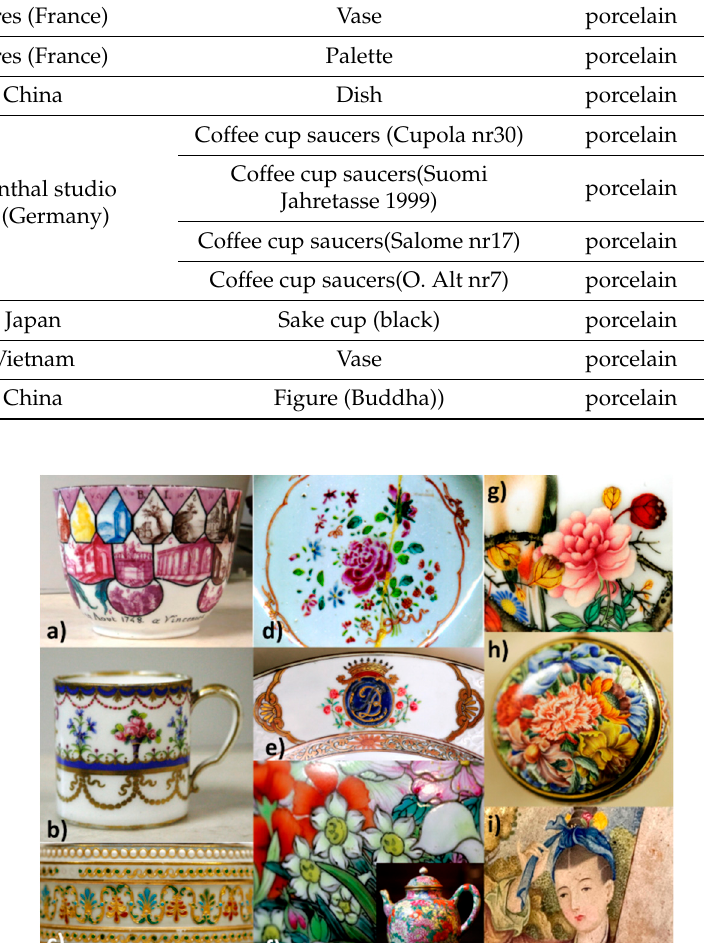
Figure 2. Selection of objects representative of the variety of colored decorations obtained with enamel on porcelain or metal during 19th century: ( a ) color palette (MNC2003, Sèvres), soft-paste porcelain enamels from Sèvres Factory, 1798, reproduced with permission from Ref. [2], 2001, J. Wiley & Sons, Inc.; ( b ) painted enameled metal ewer by Jacob Meyer-Heine, Sèvres workshop, mid- dle of 19th century (MNC21494, Sèvres), adapted with permission from Ref. [27], 2010, J. Wiley & Sons, Inc.; ( c ) color palette, hard-paste PN porcelain ‘muffle biscuit’ enamel from Sèvres Factory, after 1884, 1050 °C firing temperature reproduced with permission from Ref. [2], 2001, J. Wiley & Sons, Inc.; see reference [21] for compositions; ( d ) Satsuma small vase, end of 19th century (Private Coll.); ( e ) enameled metal pendant, Guangdong workshop, 19th century (Private Coll.); ( f , f’ British faience with Chinese-like ‘Indian’ garden pattern, W. Brownfield Factory, Cobridge, UK, circa 1870– 1880 (Private Coll.). More information is available in the references.